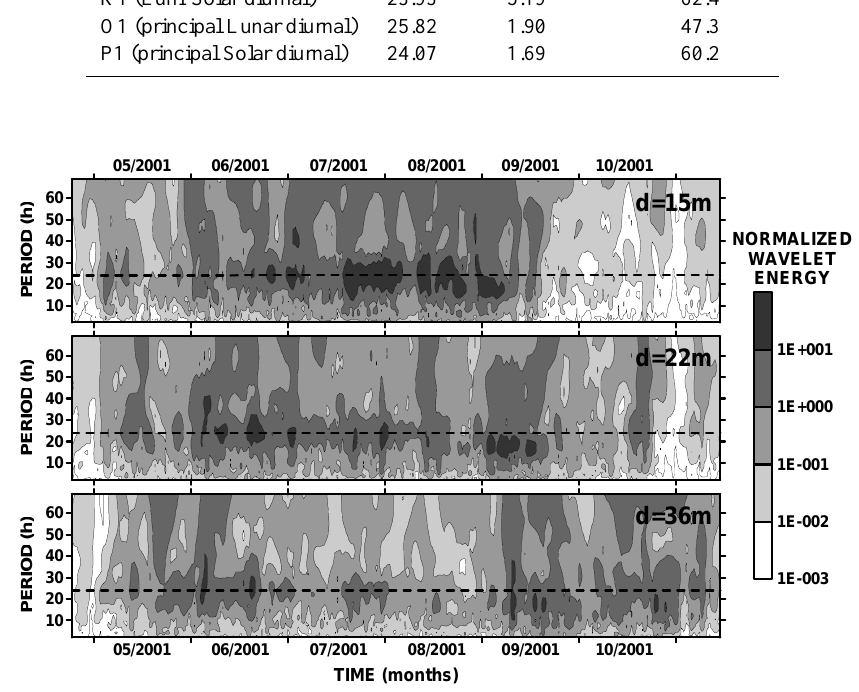
Figure 6. Wavelet spectra of sea temperature measured at Cape Struga at the depths of 15, 22 and 36 m, for the interval extending from 24 April to 14 November 2001. The spectra are normalized by the respective variances. Dashed lines denote the K1 tidal period.